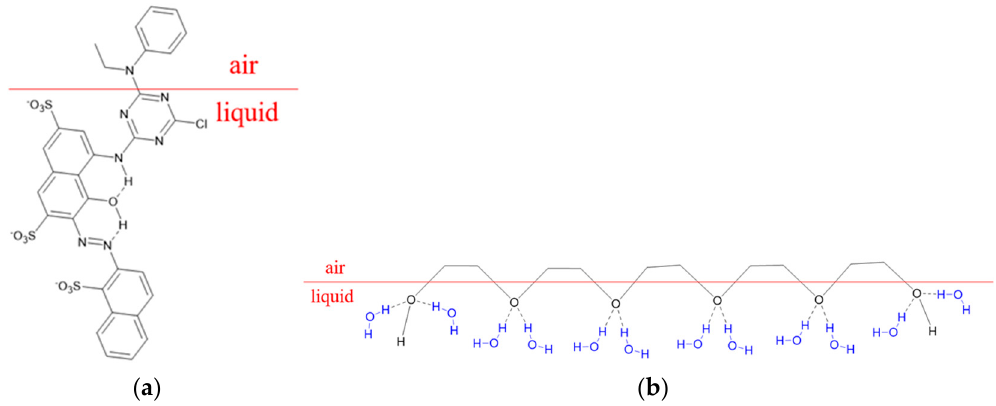
Figure 6. The arrangement of Red 218 dye ( a ) and PEG molecules ( b ) at the air/liquid interface.